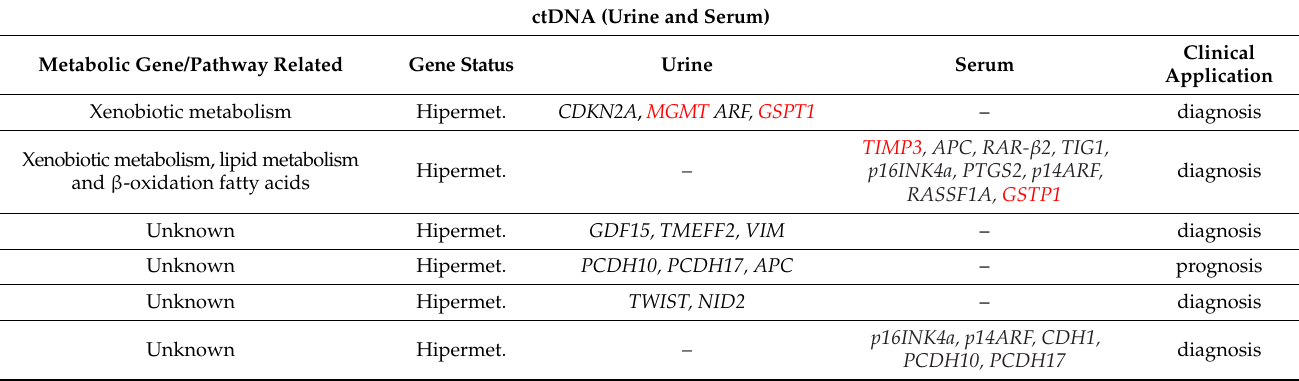
Clinical Application